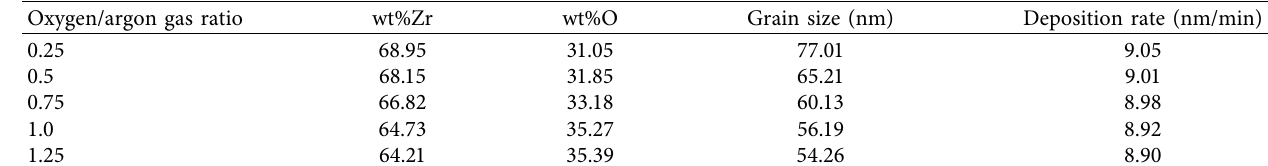
2 in oxygen/argon gas atmosphere.